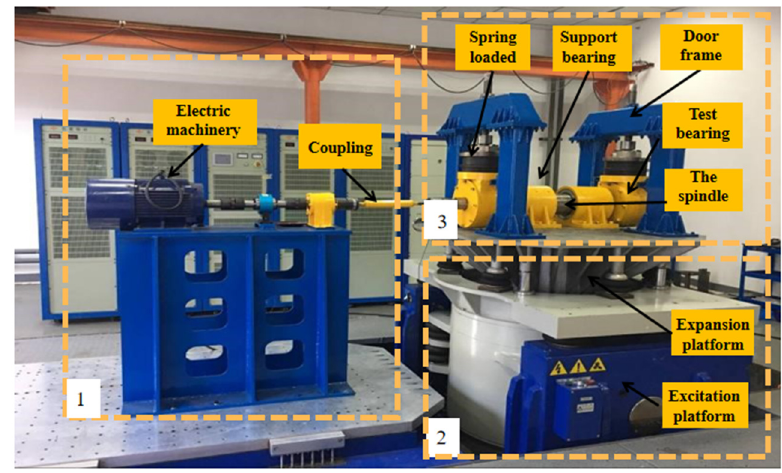
Figure 2. The design of the experimental platform.